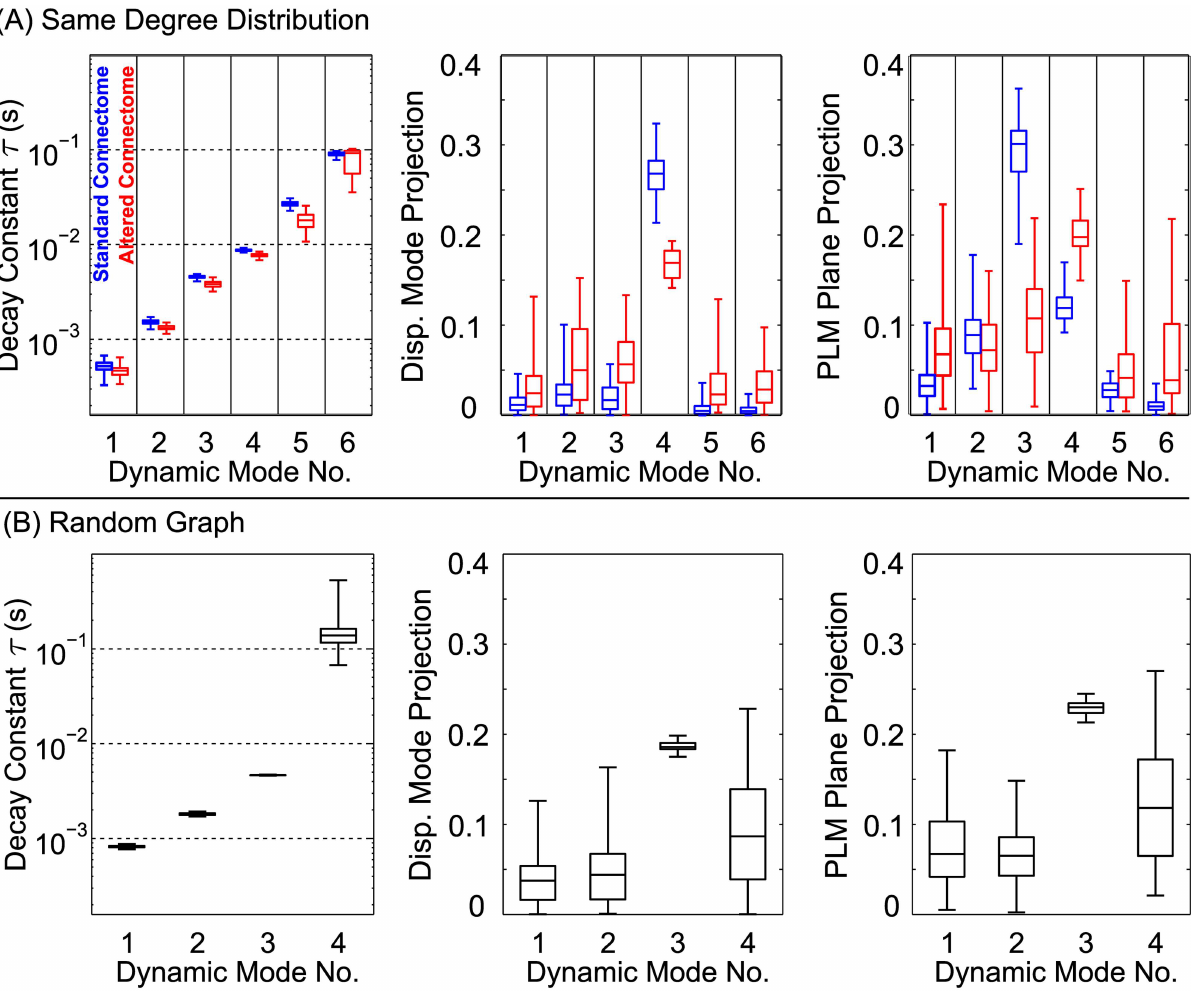
Fig 5. Analysis was repeated for different network connectivities. Each new boxplot takes data from 10 trials of 5 different randomly- generatednetworks: (A) Results from networks generatedto have an identicaldegreedistribution. The τ distributionsfor modes 2–6 are statistically different for the altered networks, but still mostly overlap. Projectionvalues (B) , however,are both statistically distinct and have very little overlapin some cases (particularly, the Displacement Mode projectionof Mode 4, and the PLM Plane Projectionof Mode 3). Results from fully random networks. Changingthe degreedistributionchangesthe numberof modes and their timescales. This shows that the dynamic modes and timescales are encodedby the network’s degreedistribution and specific connectivity. This suggests that behavioraldynamicsare partiallyencodedwithin the connectome itself, the connectivity of which facilitatesproprioceptive control.